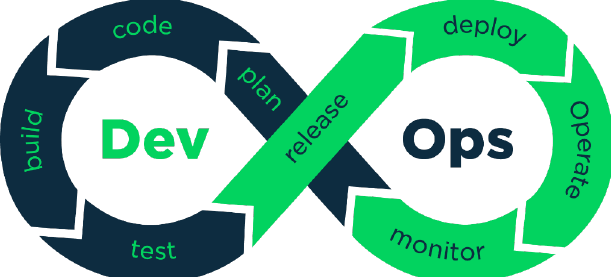
Figure 6. DevOps with the different steps that are involved during the life cycle [53].